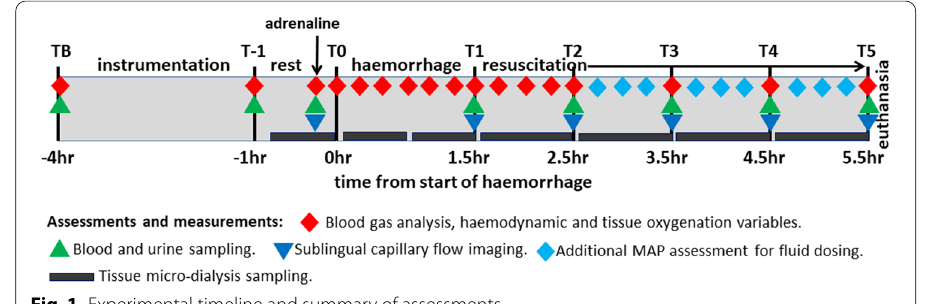
Fig. 1 Experimental timeline and summary of